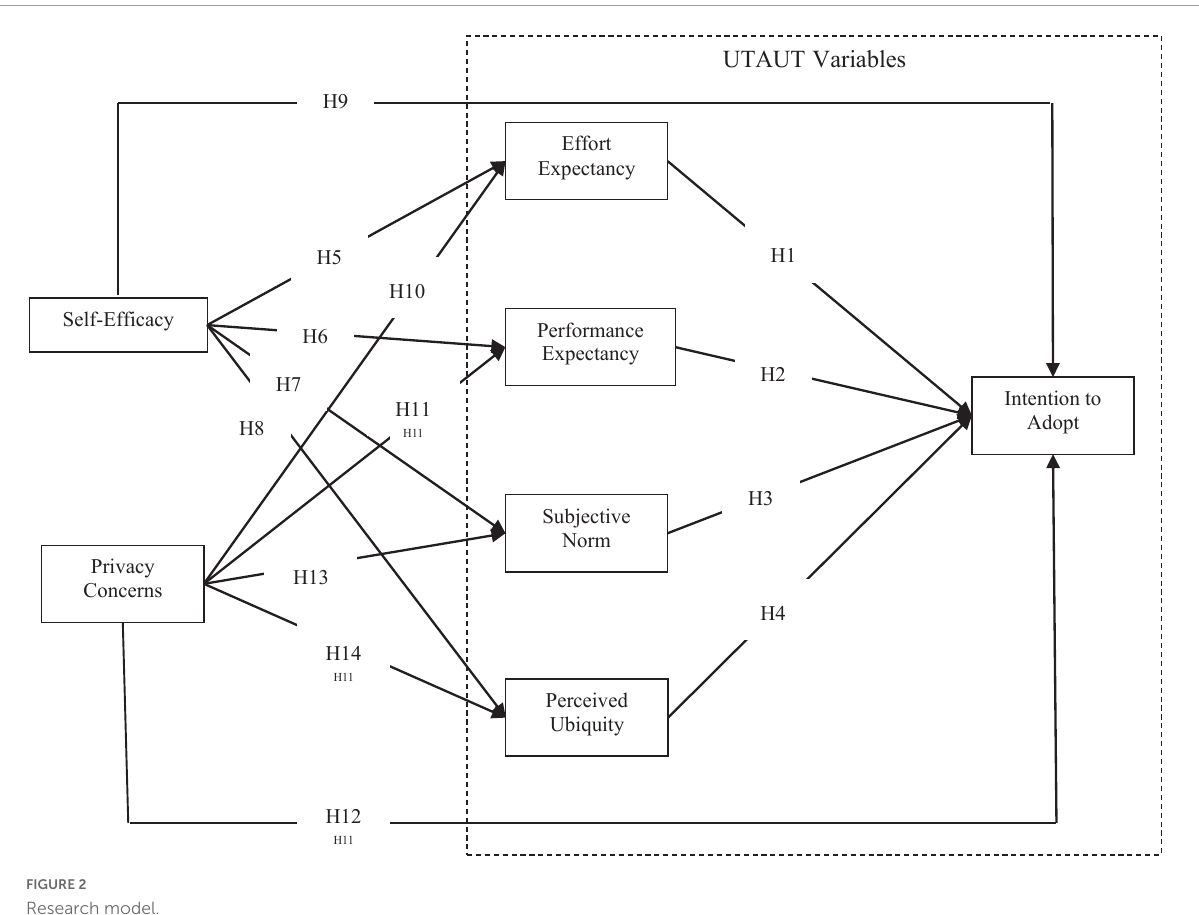
FIGURE2 Research